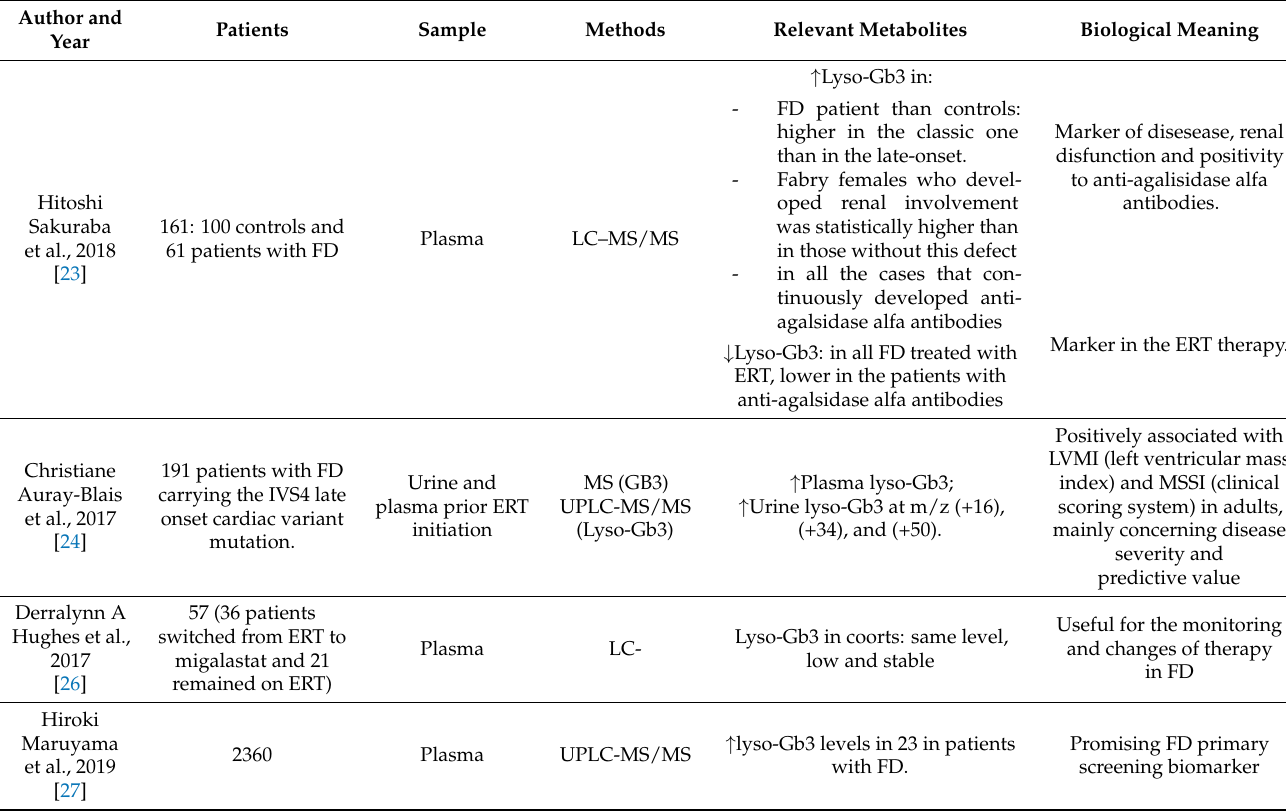
Table 2. Relevant targeted metabolomics studies in Fabry disease